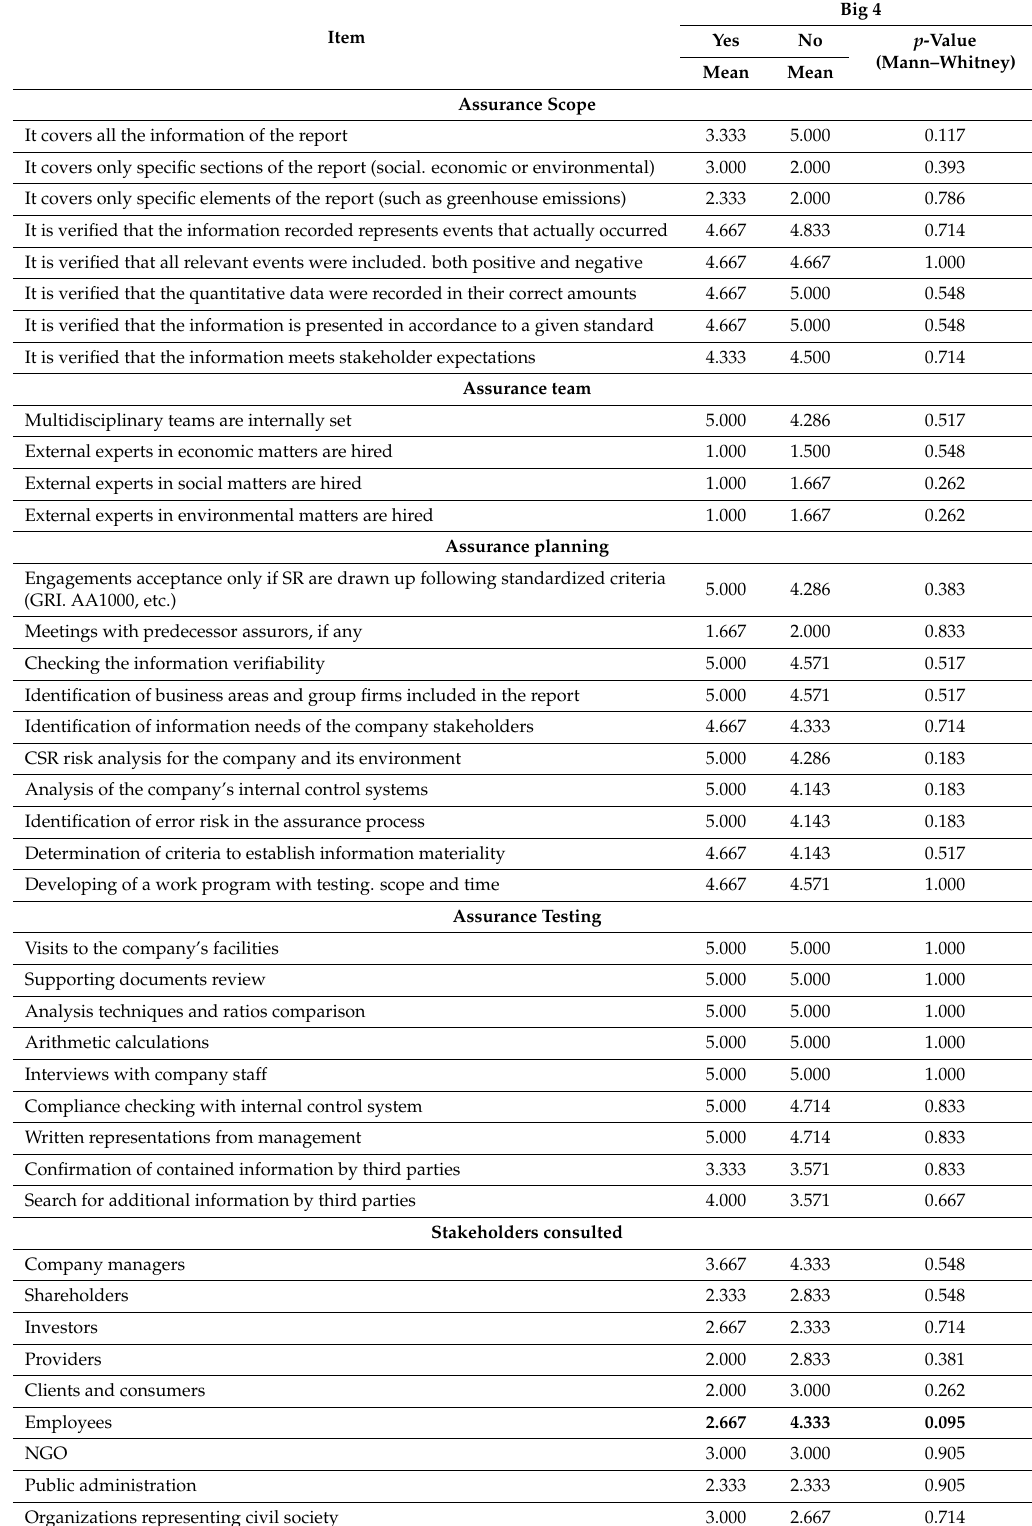
Table 11. Assurance process vs. Big